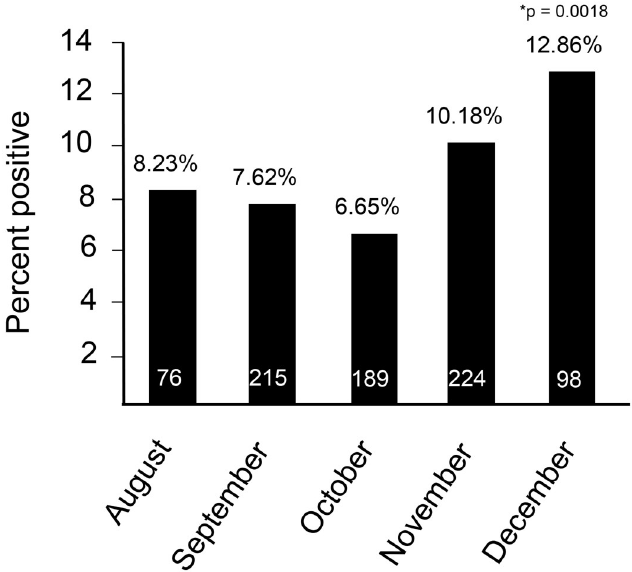
Fig 2. Percent positive S protein ELISA seroprevalence by month from August 13, 2020 to December 8, 2020. Monthly breakdown of the percent positive rate for 9550 unique donors. In August 76 of 924 donors were positive (8.225%), September 215 of 2821 donors were positive (7.621%), October 189 of 2842 donors were positive (6.650%), November 224 of 2201 donors were positive (10.177%), and December 98 of 762 donors were positive (12.861%). � p- value was determined from the z score for each month compared to the August positive rate for significance. Only December was significant as compared to August (z = -3.114, p = 0.0018 Two-tailed). https://doi.org/10.1371/journal.pone.0254667.g002 (Table 3). Rates of S protein reactivity were also analyzed by month, which showed a temporal increase, culminating in a value of 12.86% in the portion of December that was evaluated (Fig 2). Thus, the GCMA emerged into the national vaccination phase of the pandemic with a back- ground level of � 13% of individuals with some level of immunity against SARS-CoV-2 (this level is likely much higher, see Discussion). Within the donor dataset, age ranges were also evaluated for rates of prior infection. The 9550 donors spanned in age from 16 to 91 years, which was broken into roughly decade incre- ments. Interestingly, the donors from 16–30 years of age had the highest rates of antibodies against S protein compared with individuals in their 30s, 40s, and 50s while adults over 60 years of age had significantly lower rates (Table 5). Finally, gender association was 8.52% in males versus 8.28% in females, which was not statistically different (Table 5). Table 5. Rates of S protein antibody positivity by ELISA from the indicated donor age ranges or by gender. Number of donors Number of Spike OD positive Percent positive p value Age group of donors 16–30 1442 136 9.43 0.0286 1447 108 7.46 n.s. n.s. n.s. 6.98 0.0144 Sex of donors Male 4564 389 8.52 Female 4986 413 8.28 n.s. Only the 16–30 age range and the 60+ age range was statistically different from 31–40 age range, but the 31–40, 41–50 and 51–60 were not statistically different from each other. Rates in males and females were not significantly different